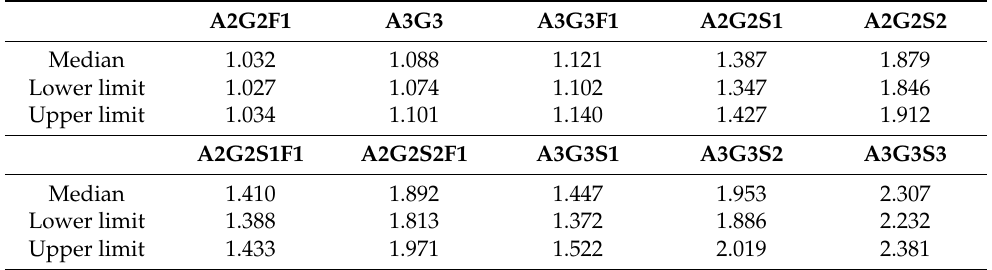
Table 2. Parameters used for calculation of retention time windows for different glycoforms.